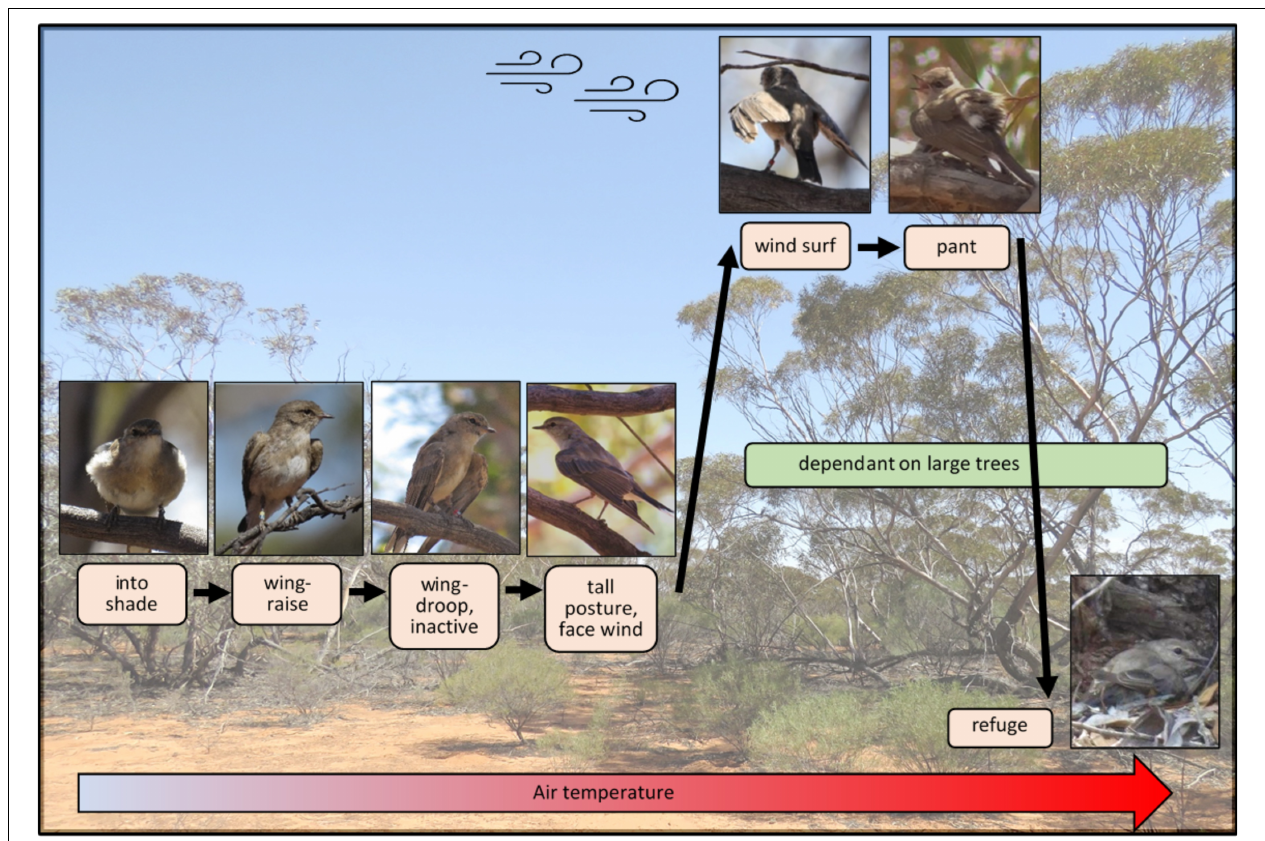
FIGURE 10 | The effect of increasing air temperature on the cooling behaviors and microhabitat use of Jacky Winters in mallee woodland.